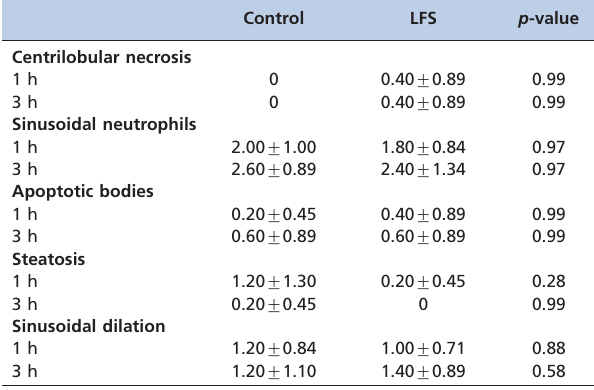
Table 4 - Results of histological analysis. There were no differences between the LFS and control